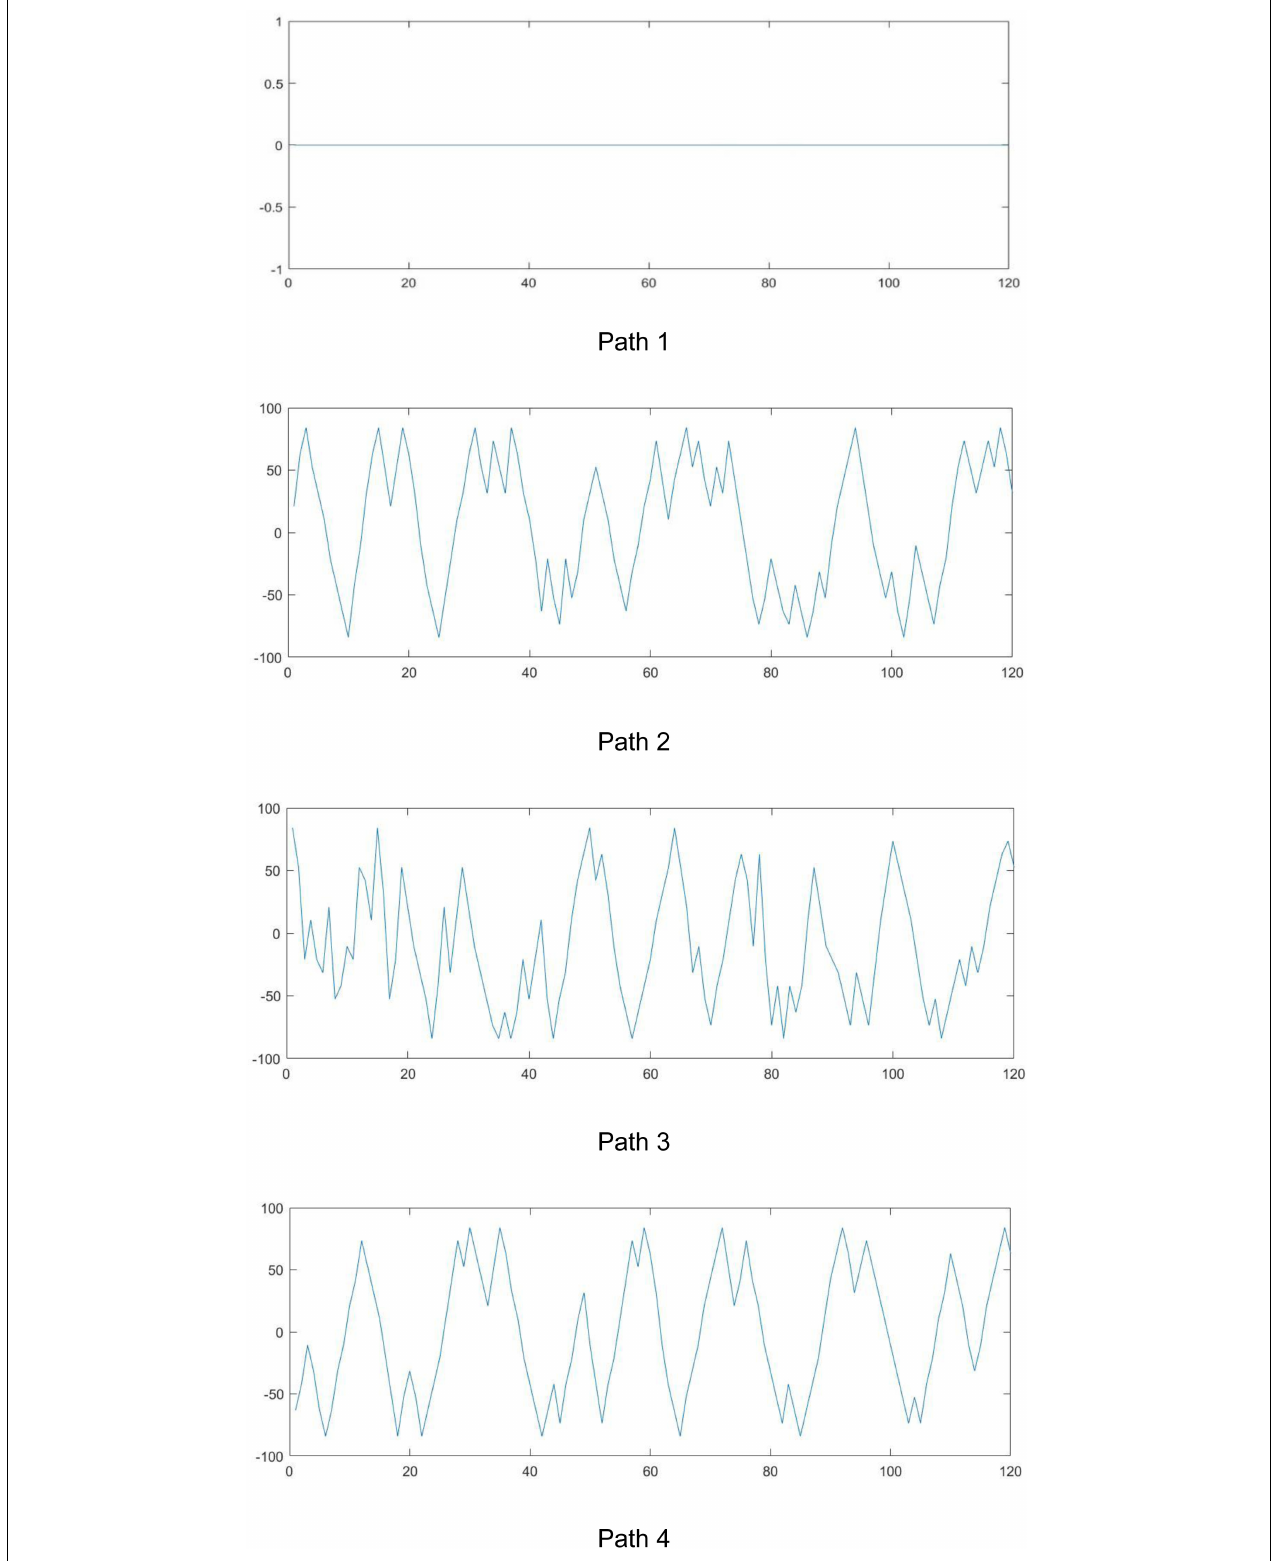
FIGURE 1 | The designed paths. The direction of walking was from left to right in each path.